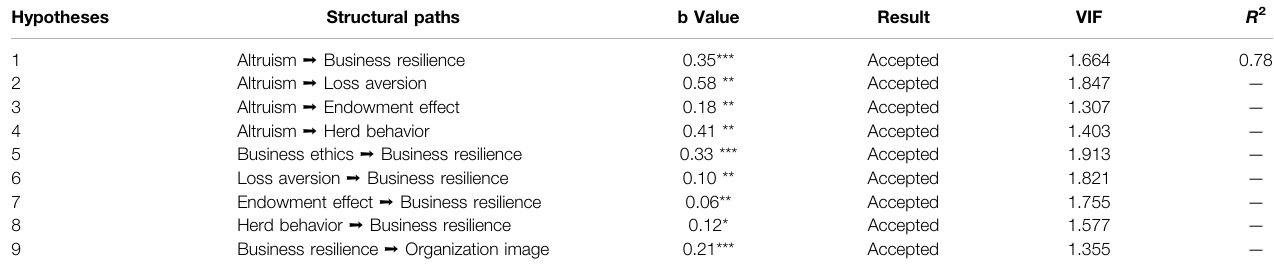
TABLE 8 | Results of hypotheses.